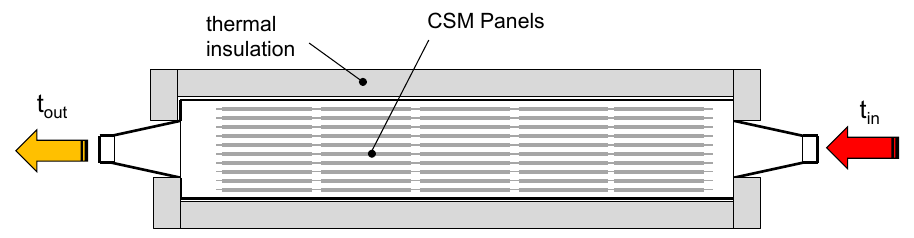
Figure 2. Schematic of the air-PCMheat exchanger. CSM, compact storage